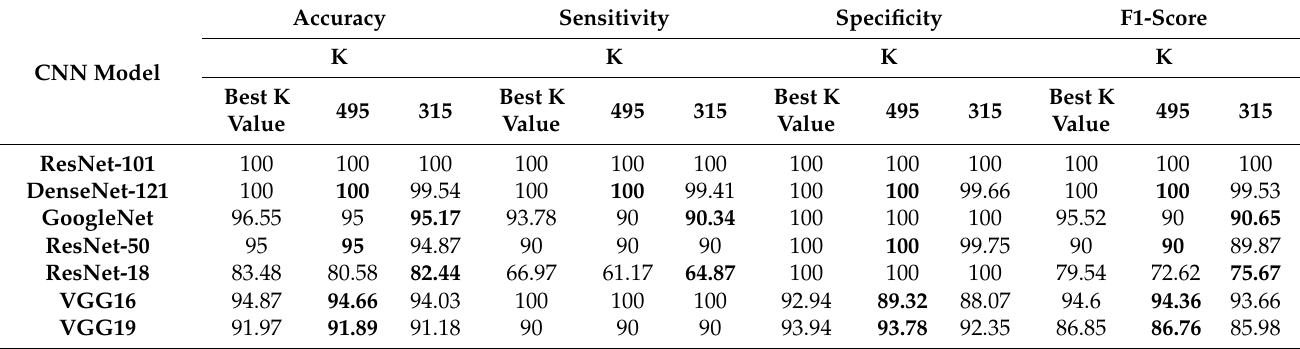
Table 3. The value of K that gives the best performance for all CNN models